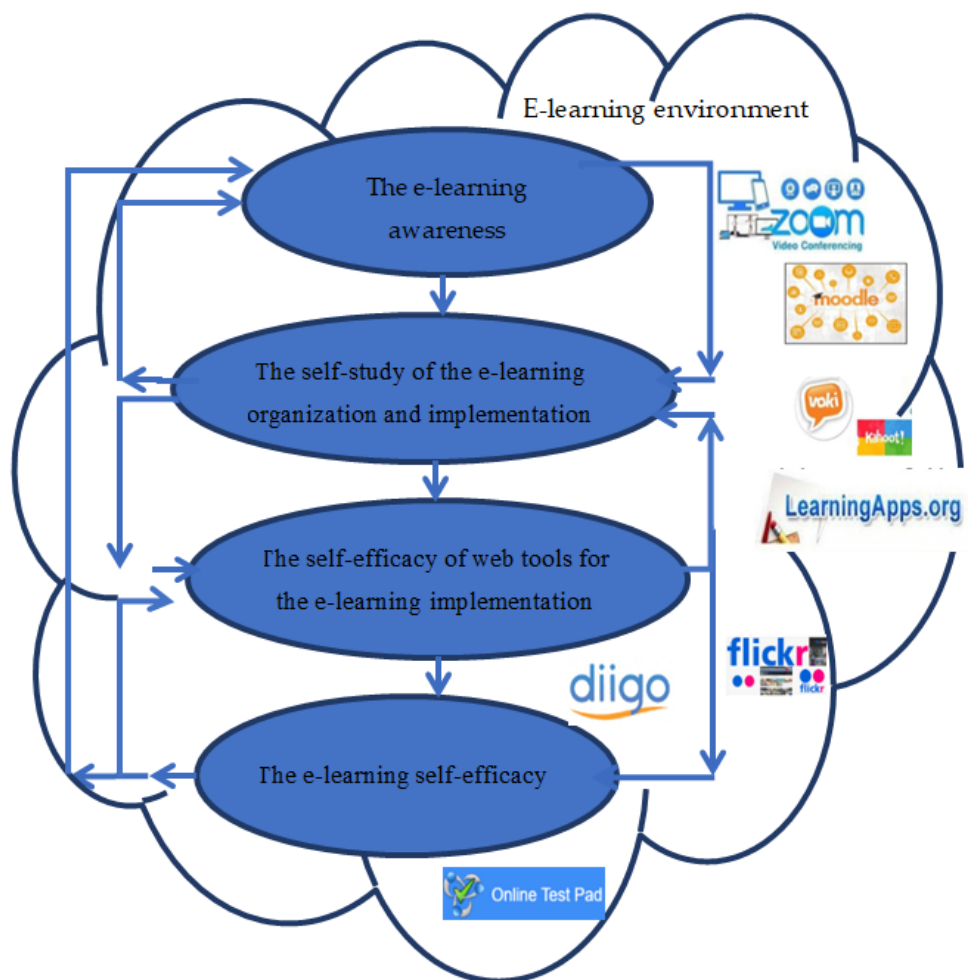
Figure 1. Model Organizing and Supporting the E-learning Process (image developed by the au-